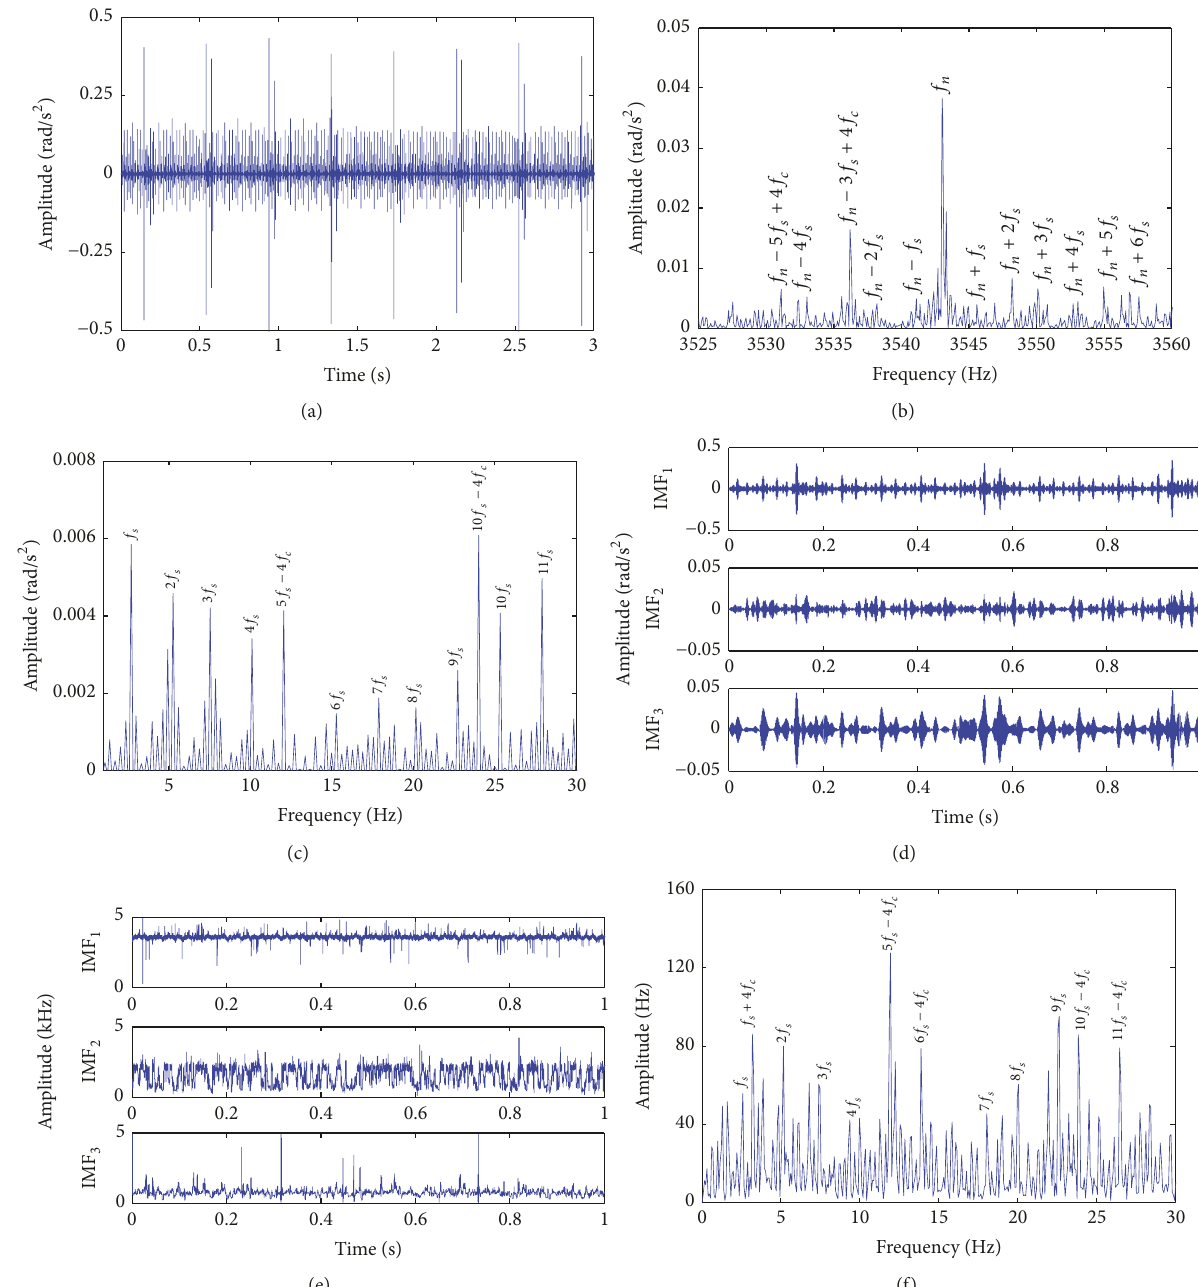
Figure 5: Dynamics modelling signal analysis: (a) torsional vibration signal, (b) Fourier spectrum, (c) envelop spectrum, (d) IMFs, (e) instantaneous frequencies of IMFs, and (f) Fourier spectrum of instantaneous frequency.